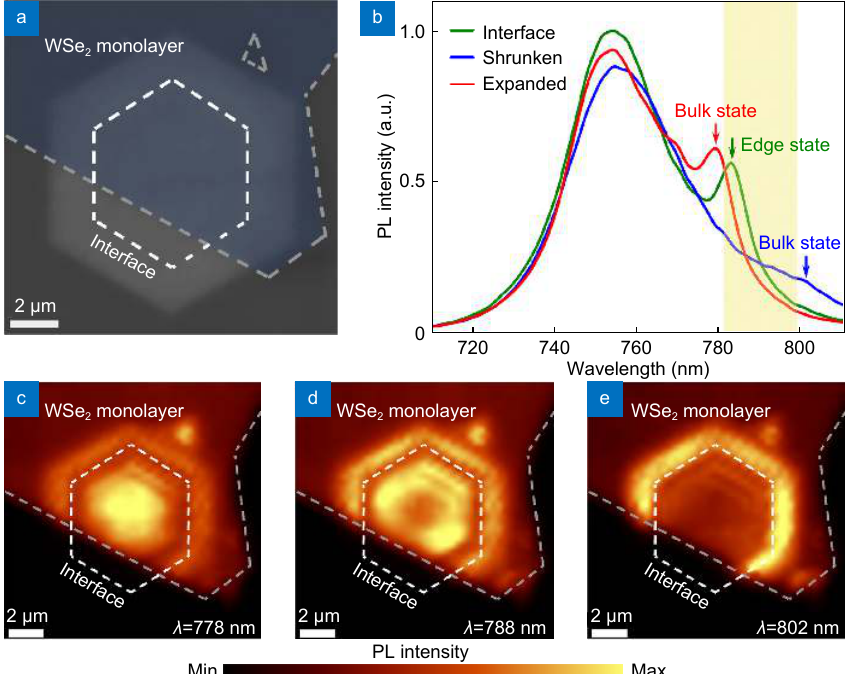
Fig. 2 | Characterization of the Z 2 topological edge state and its dark line. ( a ) Optical image of the fabricated Z 2 PTI with a WSe 2 monolayer transferred on the top. The interface between shrunken and expanded PhC regions, and the area of WSe 2 monolayer fringe are marked with white and gray dashed lines, respectively. ( b ) PL spectra collected from the WSe 2 monolayer upon the shrunken PhC (blue), expanded PhC (red), and near interface (green). The yellow shadow indicates the overlapped bandgap of shrunken and expanded PhCs. ( c – e ) PL mappings of bulk (expanded)-edge-bulk (shrunken) state at the resonance wavelength of 778 nm, 788 nm, and 802 nm. The defect triangle region of